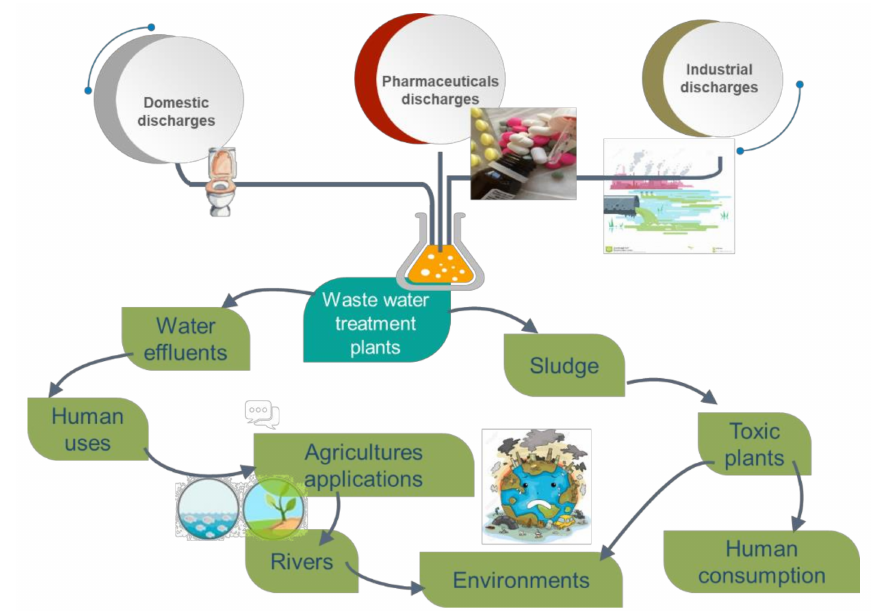
Figure 1. Sources of pharmaceutical